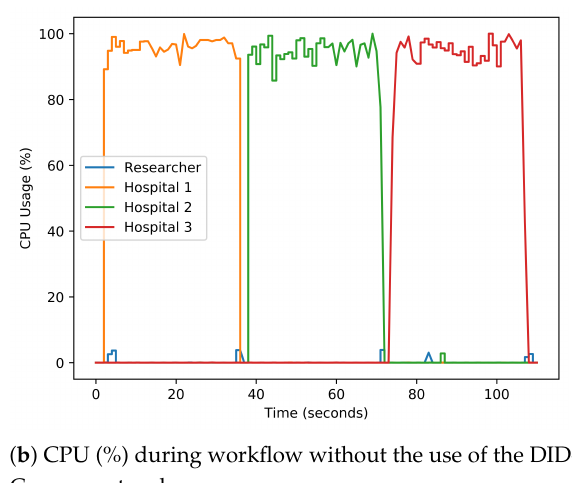
Figure 5. CPU Usage comparison of Docker containers during workflow using our novel federated learning